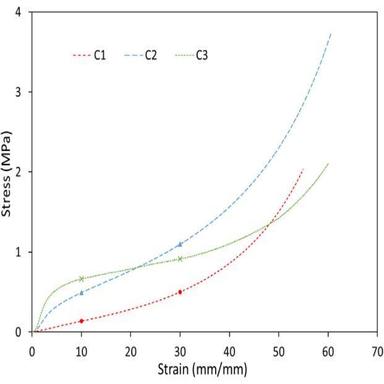
Compressive strength of the hemp based composites.